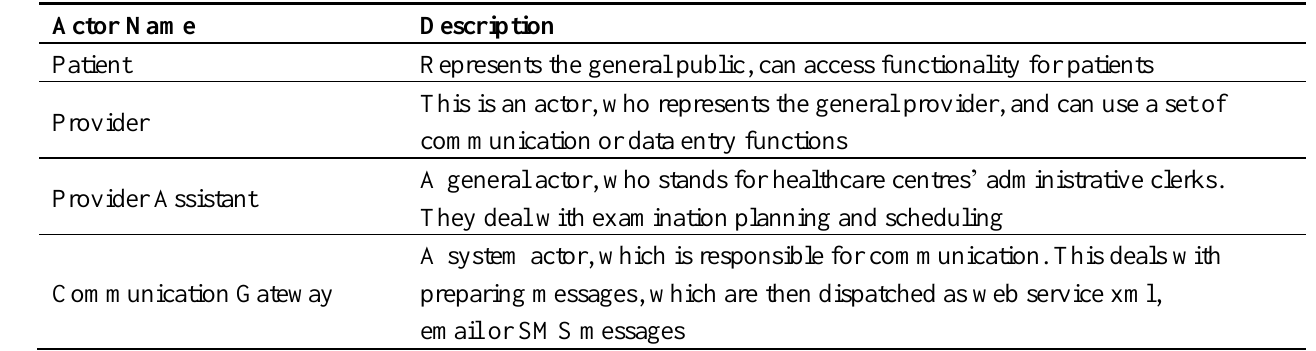
Table 1. List of primary